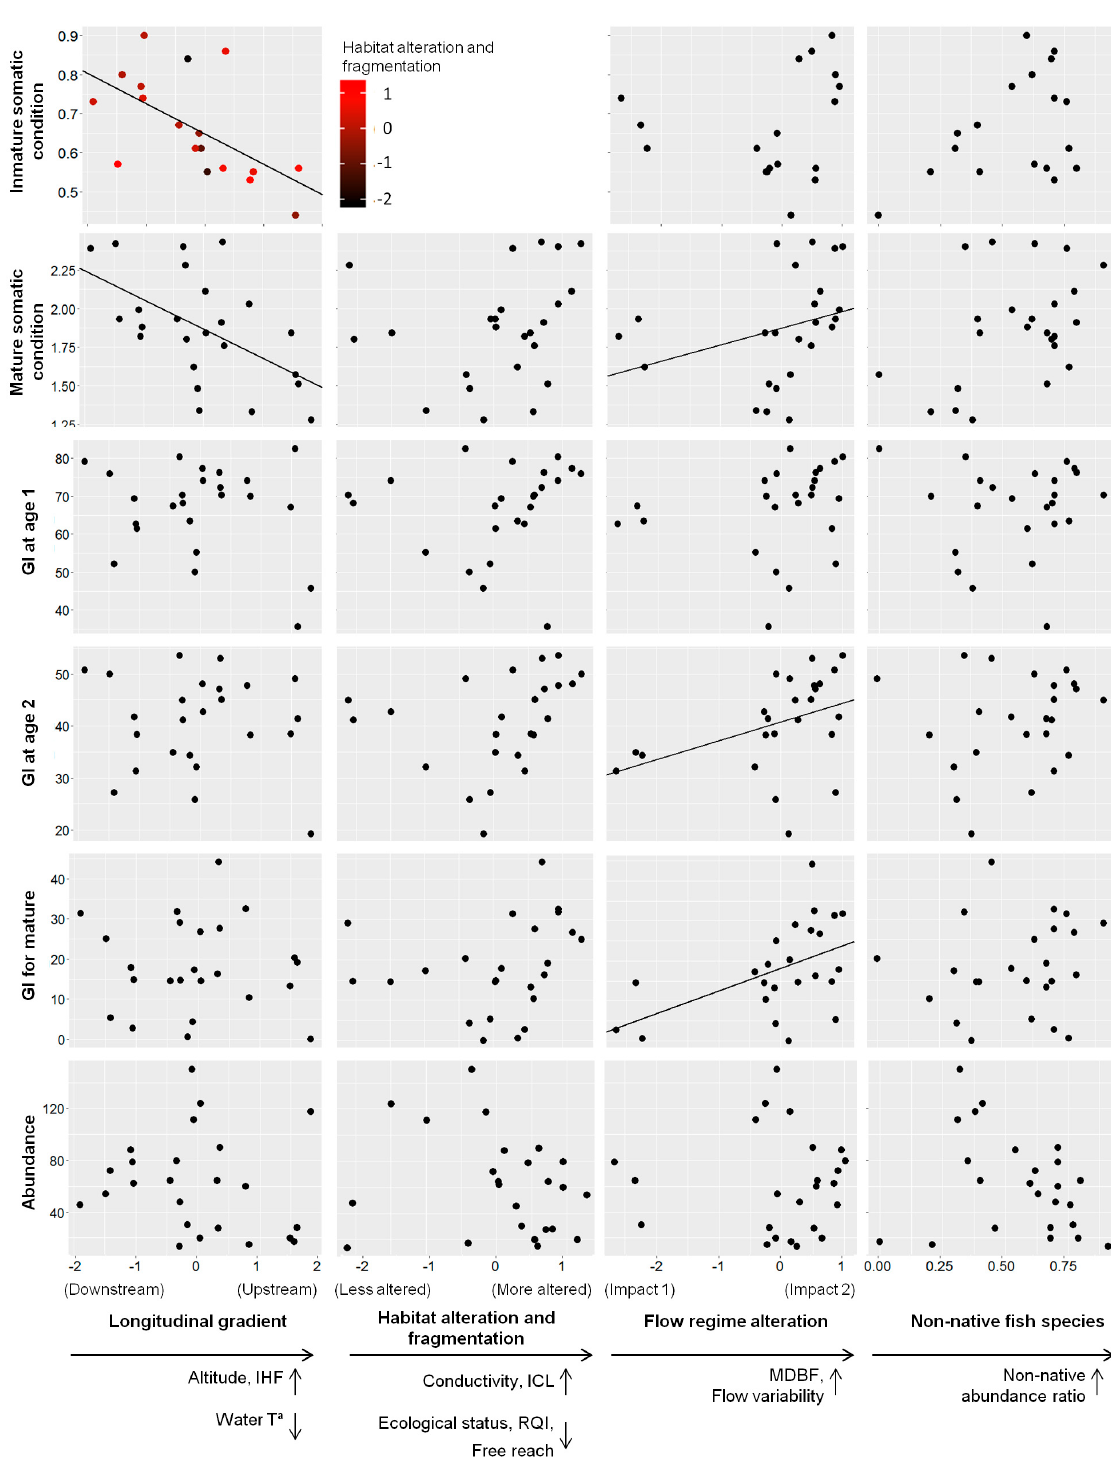
Figure 4. Relationship between environmental factors (longitudinal gradient, habitat alteration and fragmentation, flow regime alteration and non-native fish species) and L. sclateri population traits. Significant results (GLM p -value < 0.05) are represented with marked trend line on the plot. In x-axes, arrows pointing down indicate decrease in environmental variables (i.e., water temperature), and arrows pointing up indicate increase in environmental variables (i.e., altitude) and also increase in non-native abundance ratio.